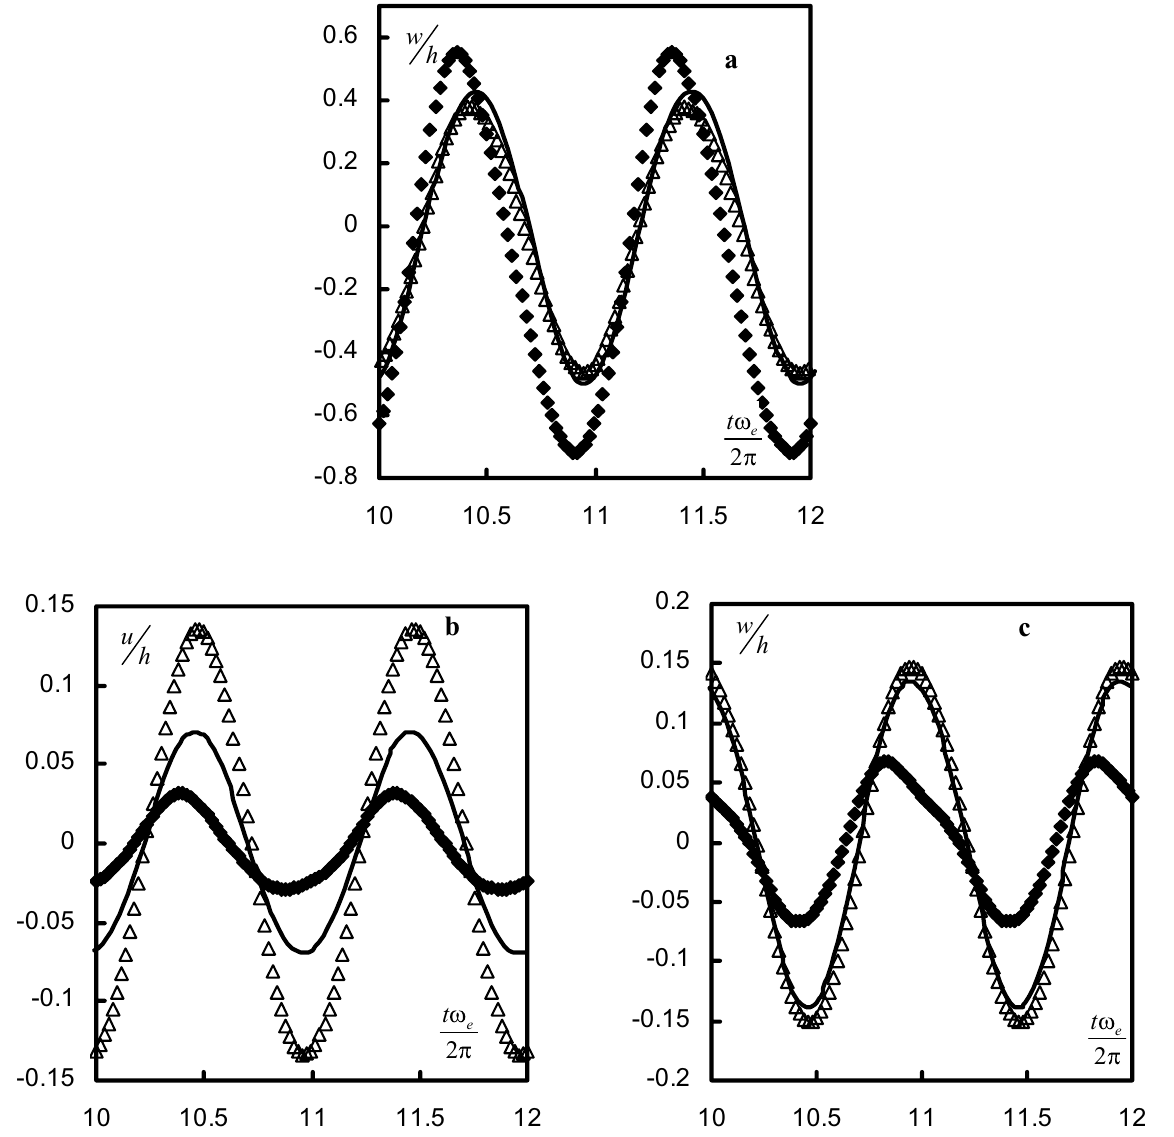
Fig. 6. Time plots of oscillations of Shells (cid:2) a/R = 0.5; — a/R = 1; ∆ a/R = 1.5, at the following points and directions: (a) Point 2, direction z ; (b) Point 1, direction x ; (c) Point 1, direction z